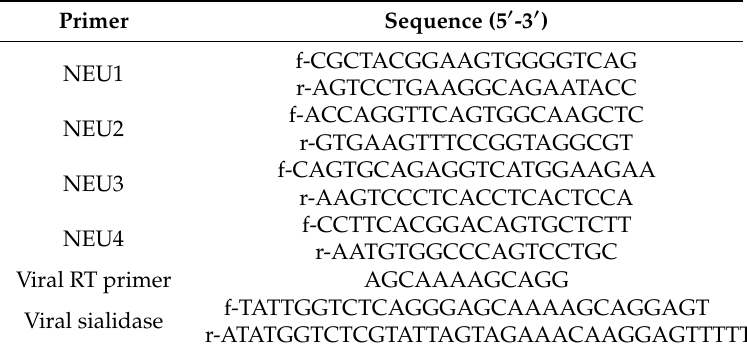
Table 1. Primers used for